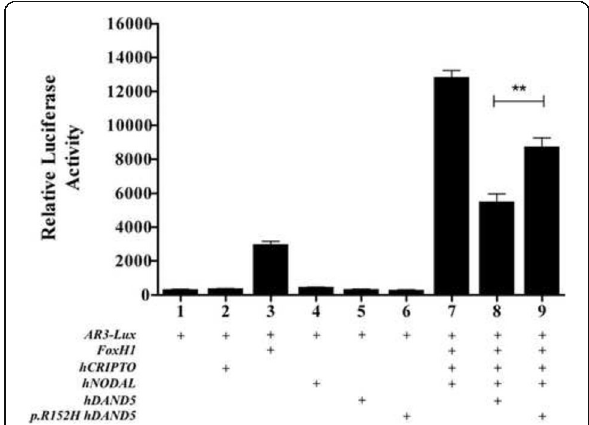
Fig. 2 Functional analysis of DAND5 variant. The identified p.R152H variant was evaluated through a luciferase assay as readout of Nodal signaling. In this assay a luciferase reporter gene under the control of three activin-responsive elements promoter, pAR3-lux, which is transcriptionally activated by Nodal signaling, was used. The results, from triplicates of three independent experiments, showed that the p.R152H DAND5 variant leads to an increase of NODAL signaling when compared to WT DAND5 protein. The effect of the different genes altogether and the individual effect for each one are shown. Data are shown as mean values from three independent experiments, with the bars indicating the S.D. Asterisks: sample with a significant difference ( P < 0.01 , t- test) calculated from comparison with